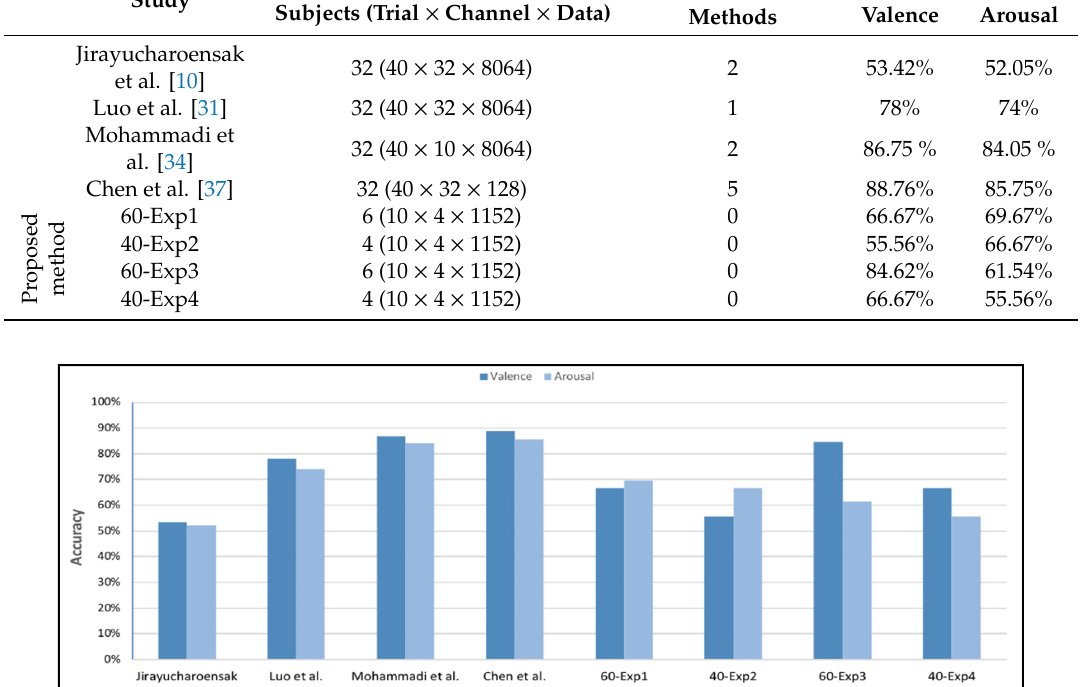
Figure 9. Comparison with other studies that used the DEAP dataset. Table 4. Comparison with other studies that used the DEAP dataset.